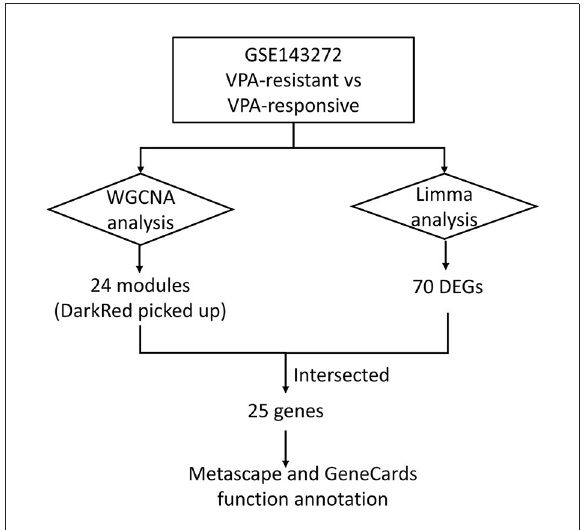
FIGURE1 The workflow of this